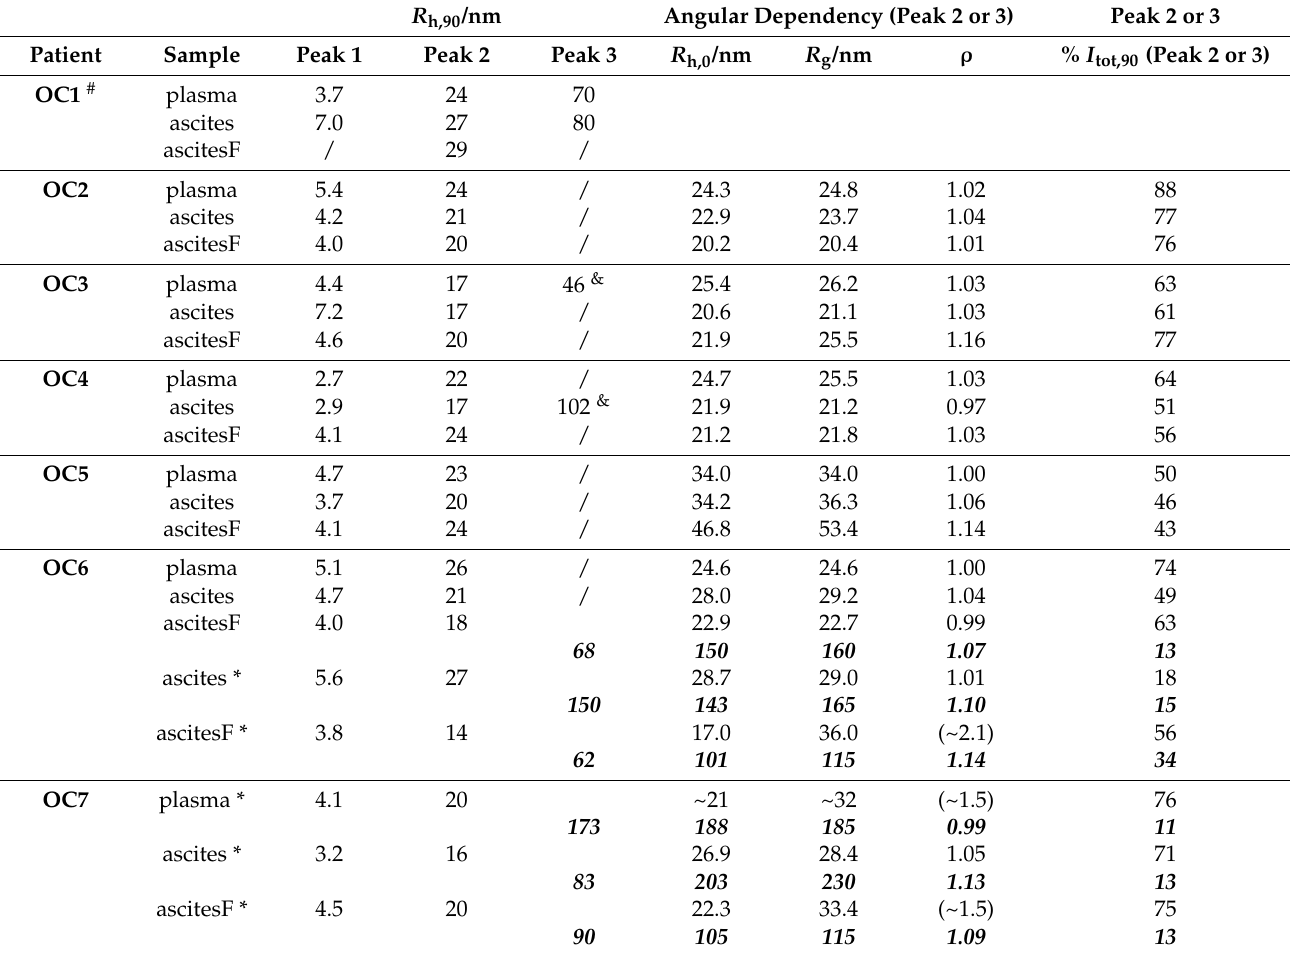
Table 2. Structural data for ENPs (represented by peak 2 and 3) determined by dynamic (DLS) and static light scattering (SLS) measurements for patients with ovarian cancer (OC): the mean hydrodynamic radius for peaks in the size distributions at an angle θ = 90 ◦ ( R h,90 ), hydrodynamic radius extrapolated to θ = 0 ◦ ( R h,0 ), radius of gyration ( R g ), the shape parameter ρ (= R g / R h ) , and the contribution of by peak 2 (or 3) particles to the total scattering intensity at θ = 90 ◦ (% I tot,90 ). The R h values in bold and italic were obtained with η o ≈ 1.2 mPa s − 1